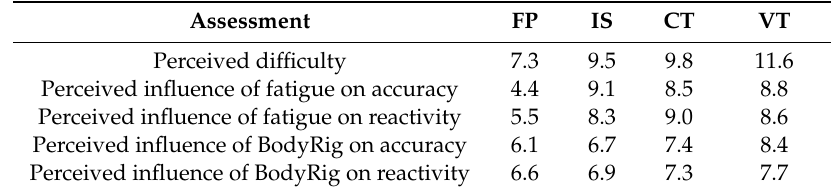
Table 3. Average scores across all subjects sorted by assessed factor and target trajectory